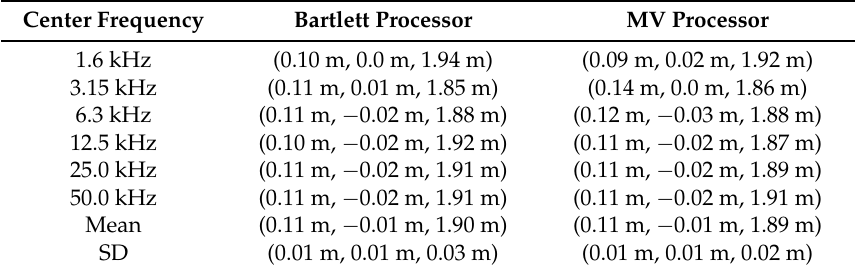
Table 1. Estimated noise source positions p x s , y s , z s q for the virtual source